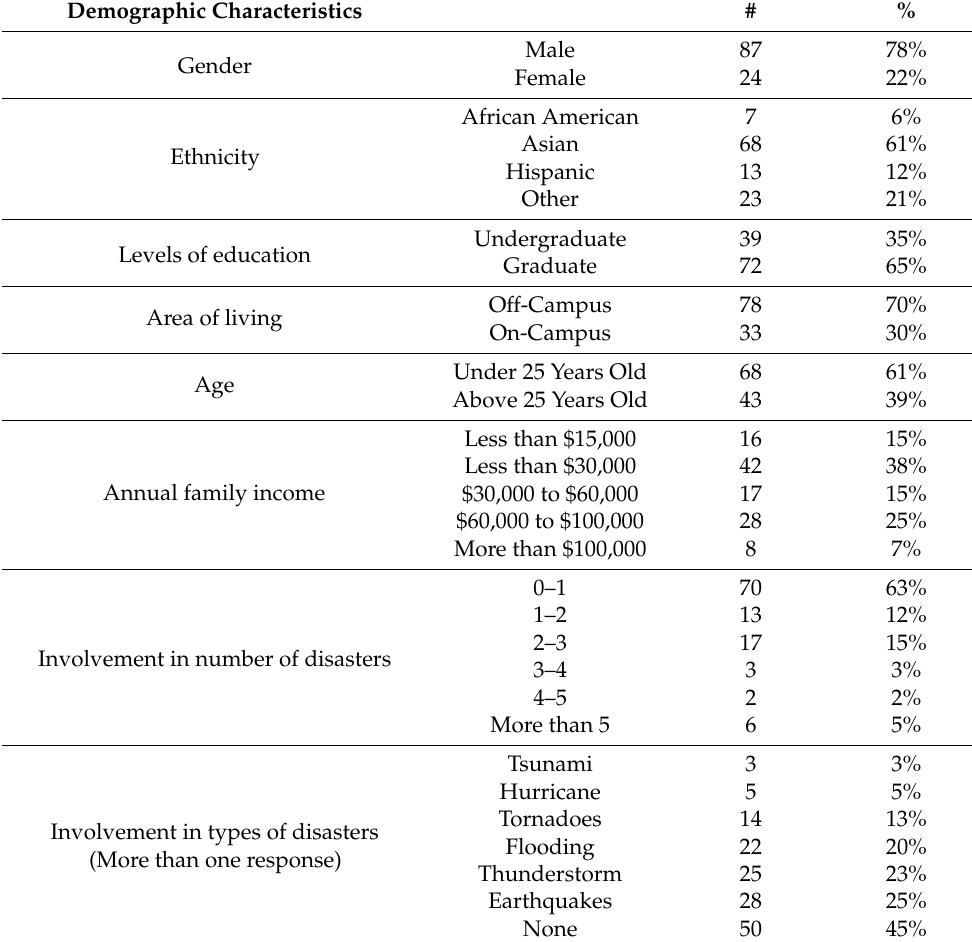
Table 2. Descriptive statistics of the survey